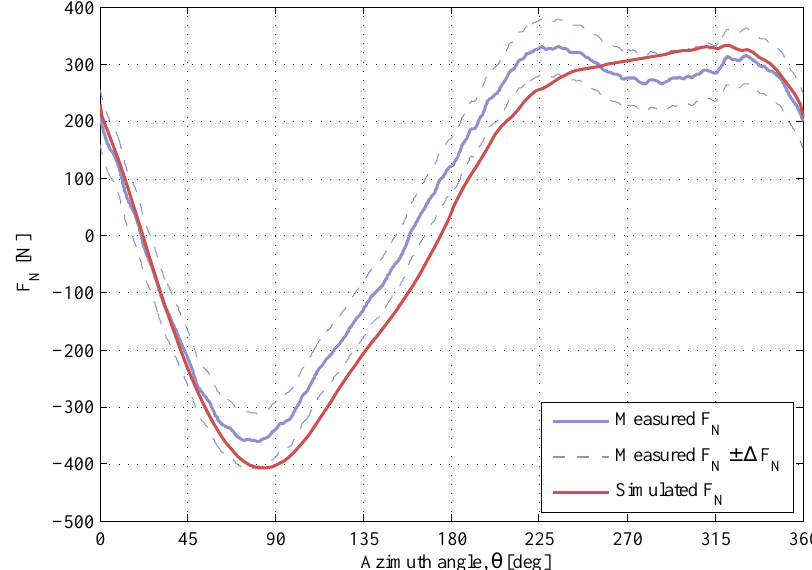
Figure 13. The normal forces at the similar λ and different Ω . The air densities and the kinematic viscosities are ρ ν = 1 . 45 · 10 − 5 m 2 / s . 2